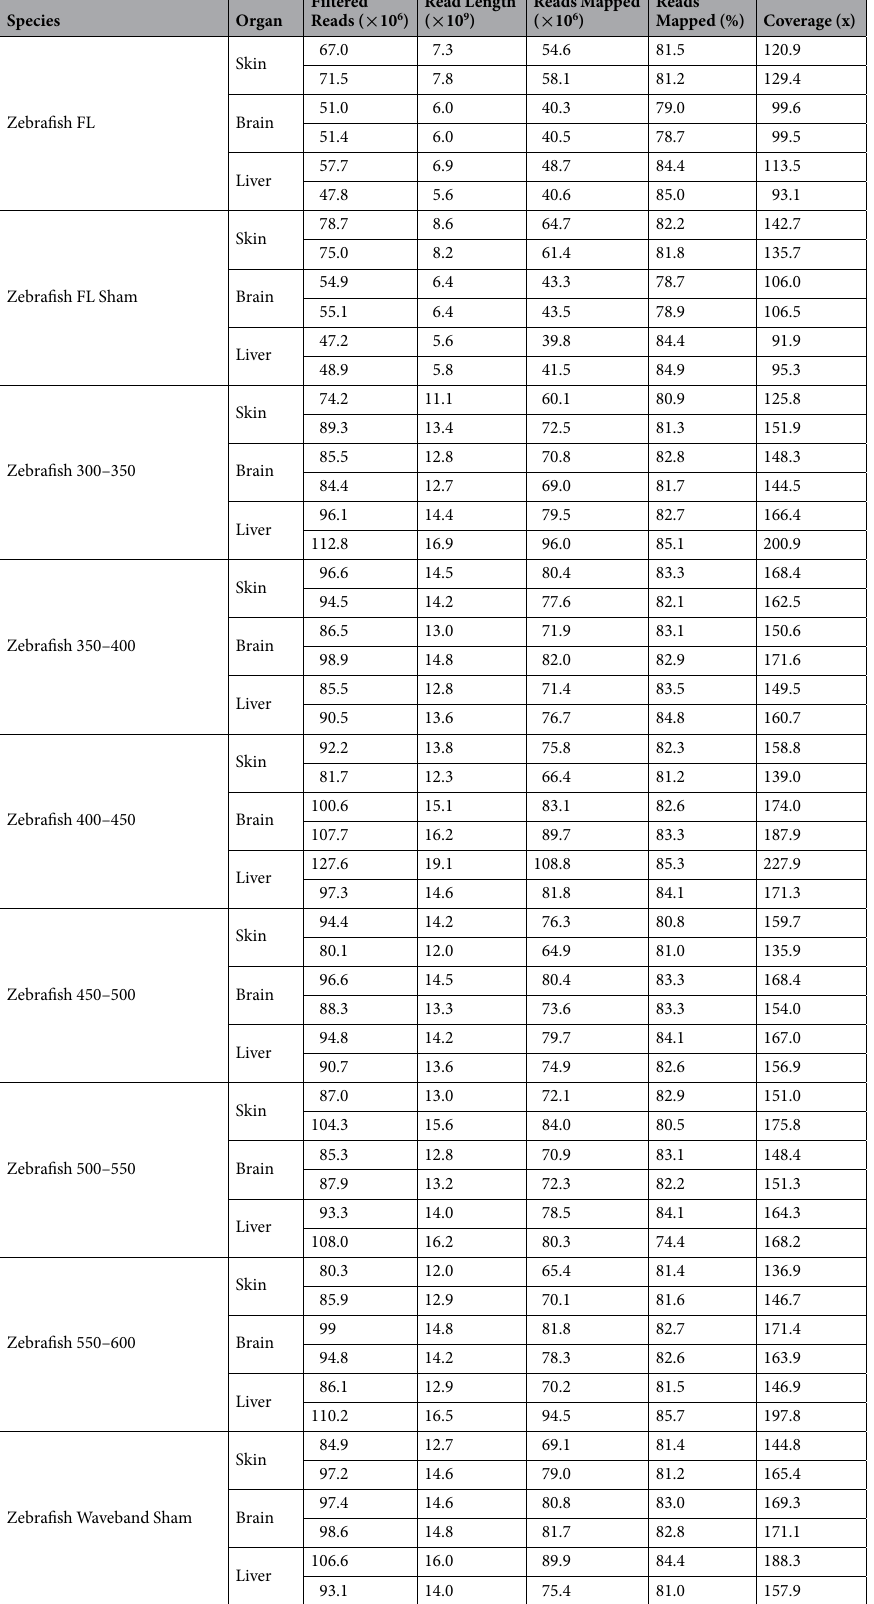
Table 4. Read depth and RNA-Seq statistics for FL exposed, sham and specific waveband treated zebrafish